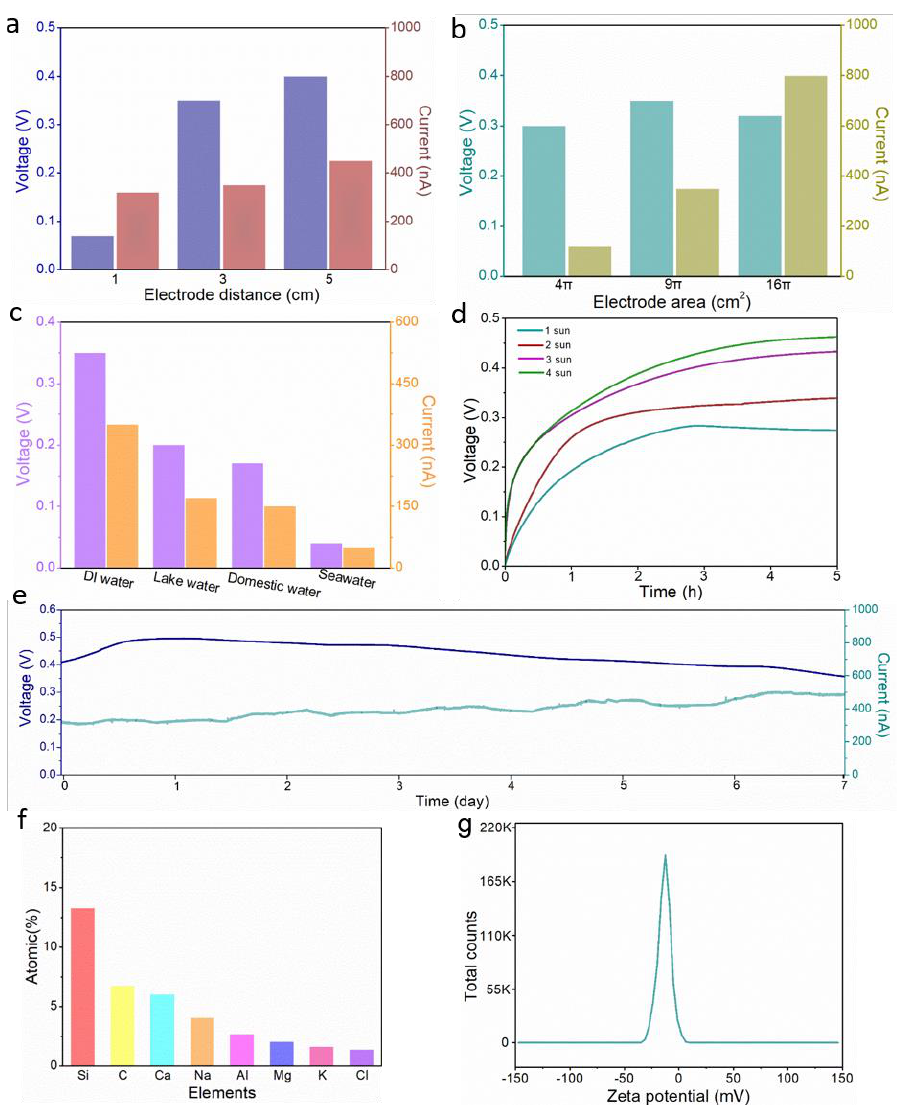
Figure 4. ( a ) Output voltage and current of different electrode distances; ( b ) Output voltage and current of different electrode areas; ( c ) The effect of water type on the induced electrical signals (ion concentration from low to high: deionized water < lake water < domestic water < seawater; lake water was taken from the Beijing Institute of Technology Lake, and seawater was taken from the Yellow Sea of China); ( d ) Induced voltage of ISUM under different sun irradiation; ( e ) Stability test of ISUM under 1-sun irradiation; ( f ) EDS analysis of dissolved rocky land supernatant; ( g ) Zeta po- tential of rocky land. The atomic percentage of soluble salt elements dissolved in the rocky land detected by EDS in Figure 4f shows that the rocky land contains a small number of soluble metal cations. According to the flow-potential principle, the induced voltage depends on the directional flow of water as well as the Zeta potential of the material surface. As shown in Figure 4g, the zeta potential of the rocky land particles is –12.8 mV, indicating that their surfaces are negatively charged under neutral conditions (see Figure S13in the Supporting Information for details of the surface zeta potentials of other selected soils). When water evaporation-driven molecules and ions pass through capillary channels formed by nega-